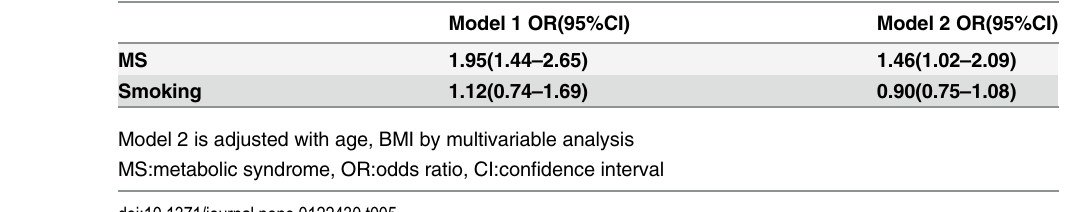
Table 5. Odds Ratios of Metabolic Syndrome and Smoking to Coronary Artery Calcification.